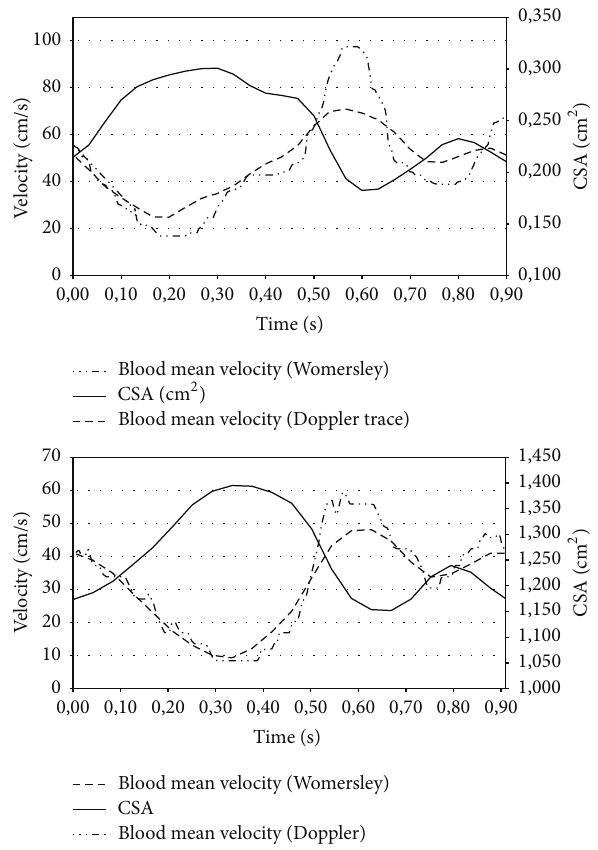
Figure 5: Ultrasound spectral Doppler mean velocity ( 𝑤 ) is plotted together with the internal jugular vein blood mean velocity ( 𝑤 ) calculated using Womersley equations. A single cardiac cycle is